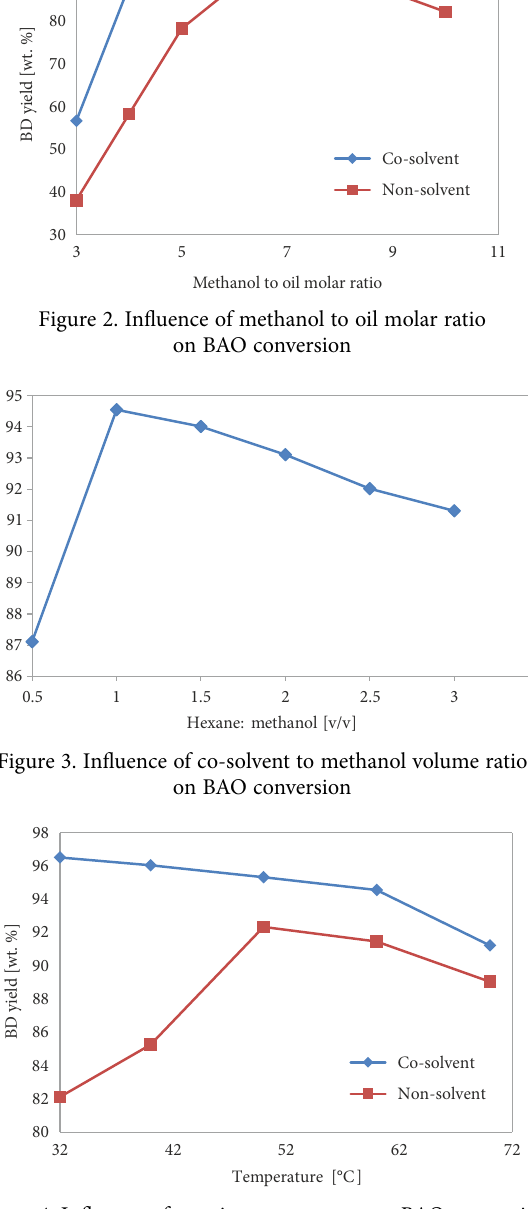
Figure 4. Influence of reaction temperature on BAO